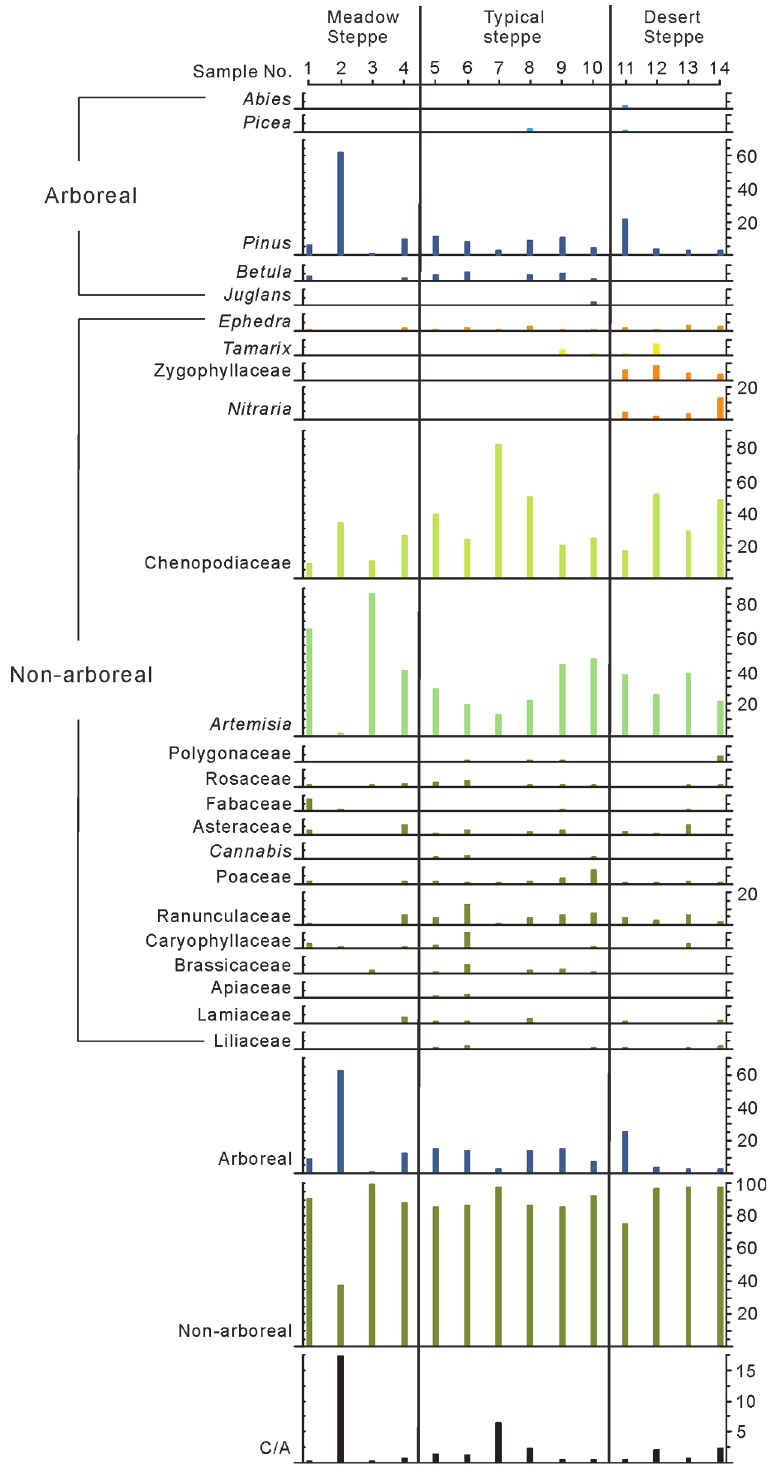
Fig 2. Surface pollen spectra of meadow steppe, typical steppe and desert steppe in Inner Mongolia, China.